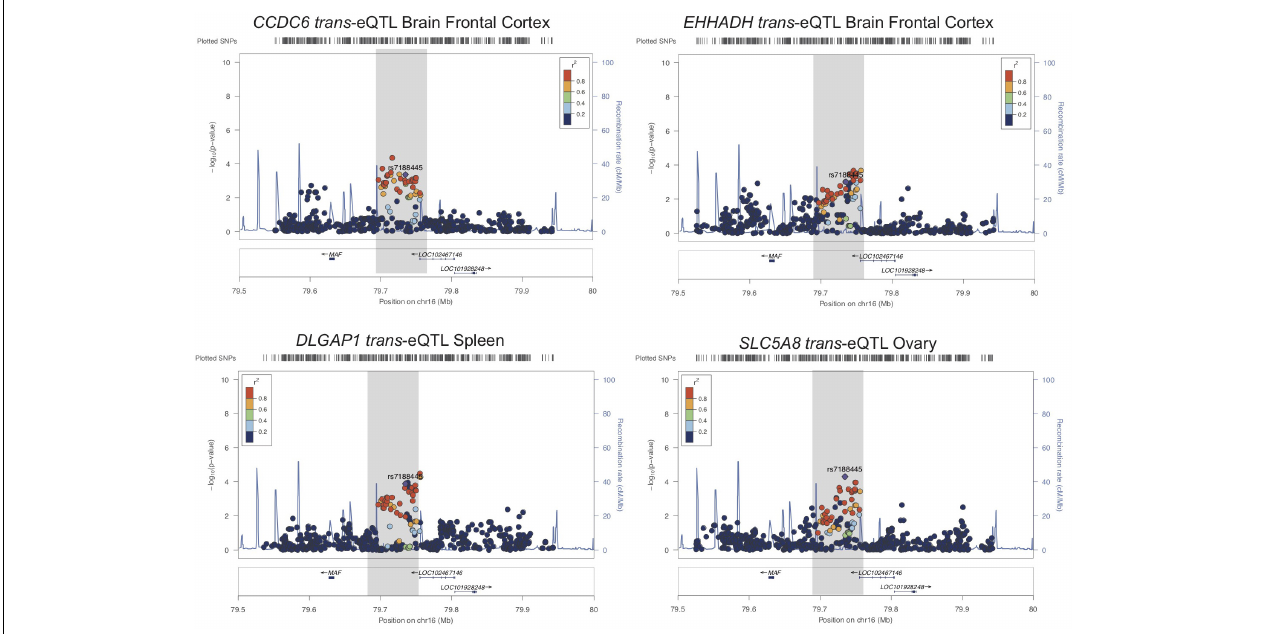
FIGURE 5 | SUA1 connects with and associates with expression of genes in trans. Regional association plots for four trans -eQTL at SUA1 implicated in serum urate and kidney relevant pathways. Dots indicate individual SNPs while their position relative to the left Y -axis indicates significance [ − log 10 ( p -value)] of association to serum urate levels. The blue line indicates the recombination rate across the locus. The SUA1 region upstream of MAF is indicated by a gray box. rs7188445 (the lead SUA1 urate SNP) is indicated by a purple dot. The color of the surrounding SNPs indicates the strength of LD with rs7188445 according to the key in the left top hand corner, measured as r 2 found in the HapMap data (hg19/1000 genomes Nov 2014) for Europeans. The plot was generated using LocusZoom (Pruim et al., 2010).